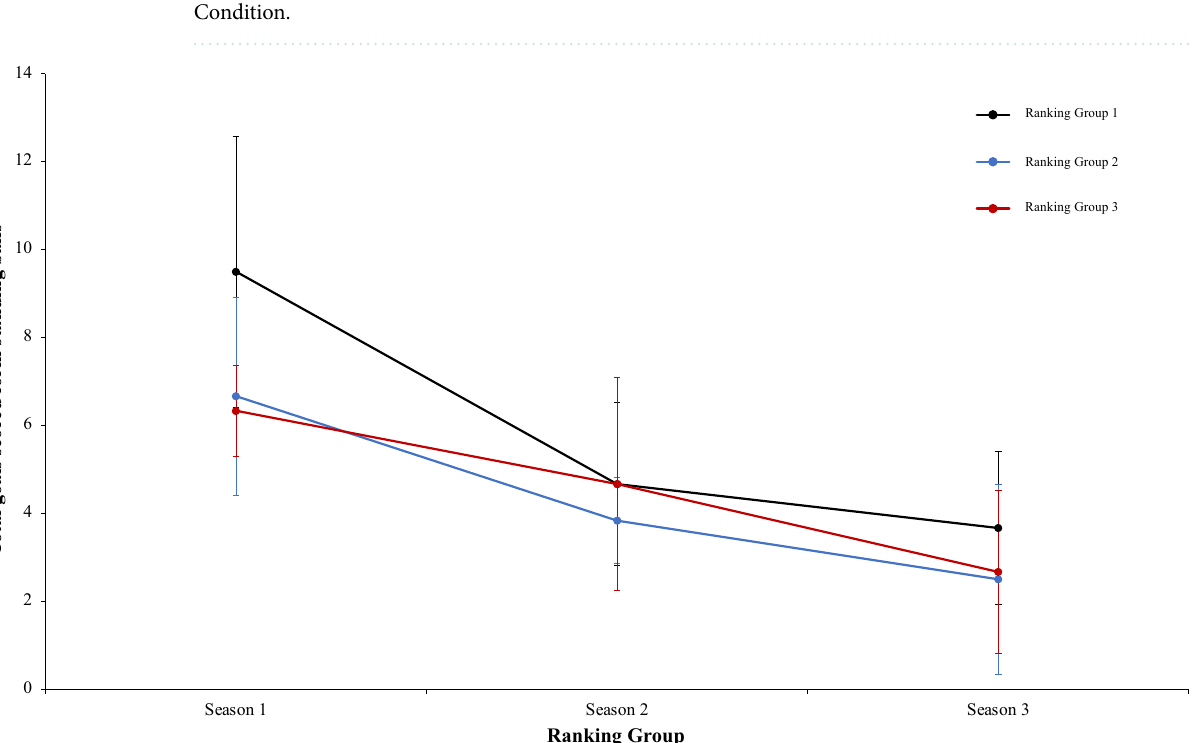
Figure 20. Technical performance. Mean total goals scored form standing balls (± SE) as a funtion of Ranking and Season goal scored from standing balls (mean and SE)] as a function of ranking group and season condition are shown Table 4. Continuing with the same analysis of present work, a two-way mixed ANOVA with ranking group means total goal from a corner, revealed a significant main effect of season condition, F (2.4) = 4.51, p = 0.001, η 2 = 0.49. However, main effect of ranking group condition, F (2.4) = 1.27, p = 0.37, η 2 = 0.38, and interaction between